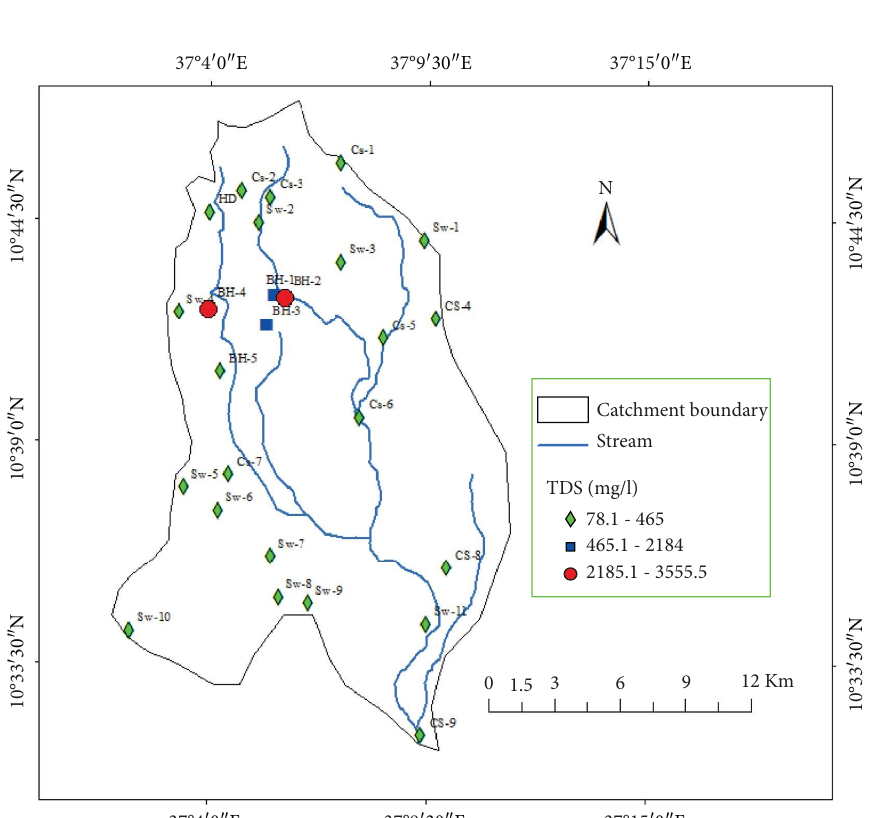
Figure 6: Spatial variability map of EC.